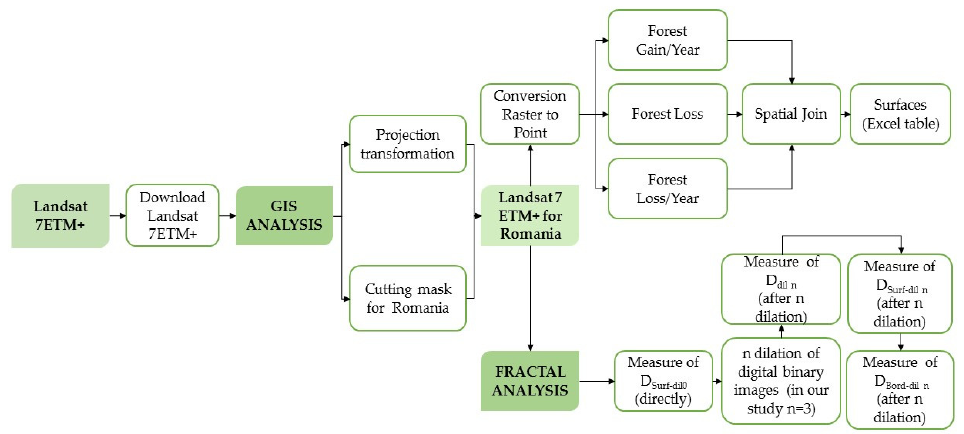
Figure 2. Workflow of data pre-processing, GIS analysis and fractal analysis of deforestation processes for Romania.